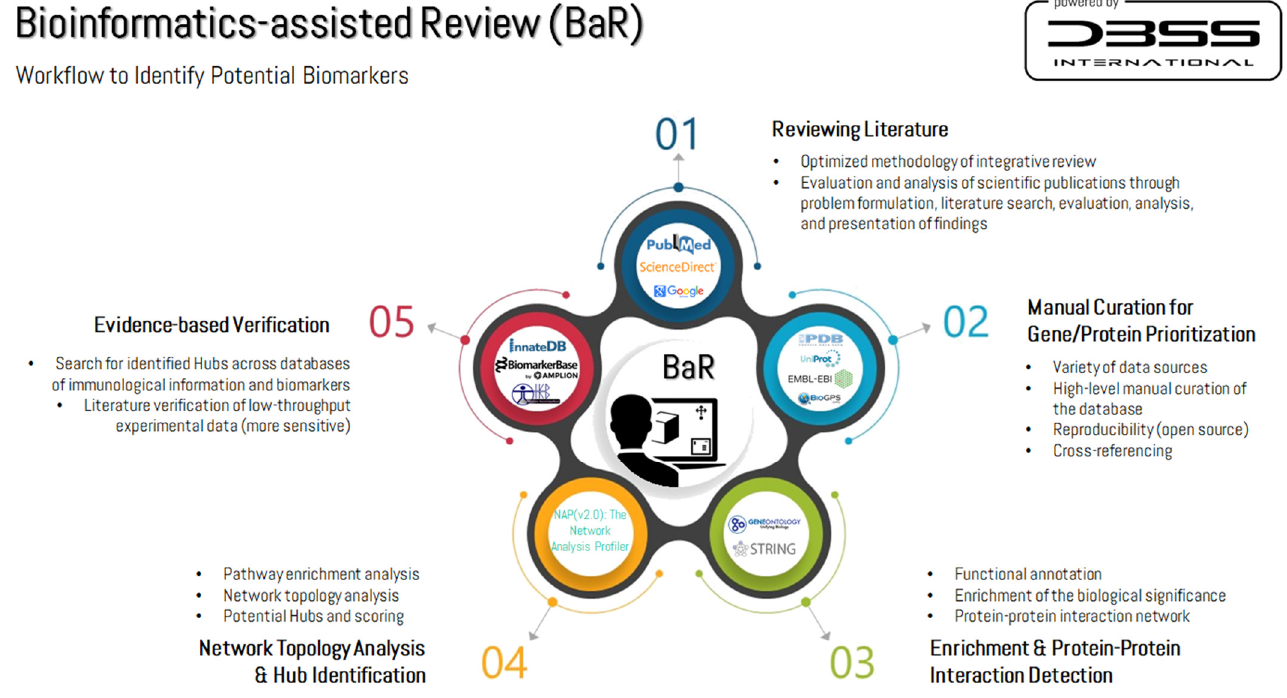
Figure 2. Overview of the bioinformatics-assisted review workflow to identify potential biomarkers.